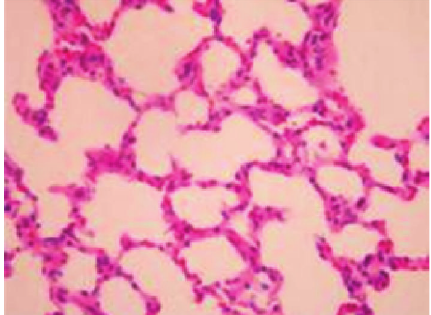
Figure 5: Treated group 21 days; obvious glomerular congestion and renal tubular degeneration; HE × 200.